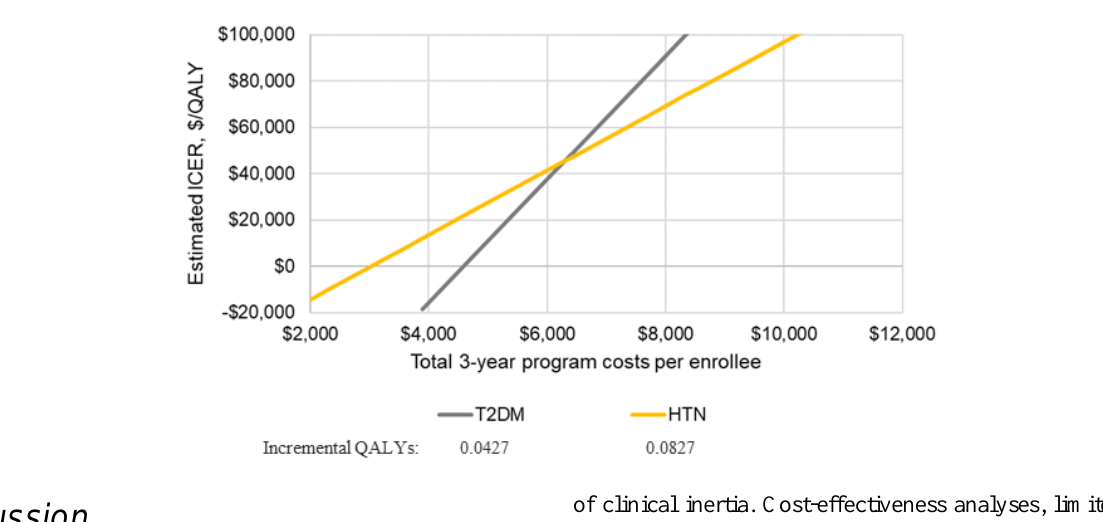
Figure 4. Cost-effectiveness threshold curves by patient